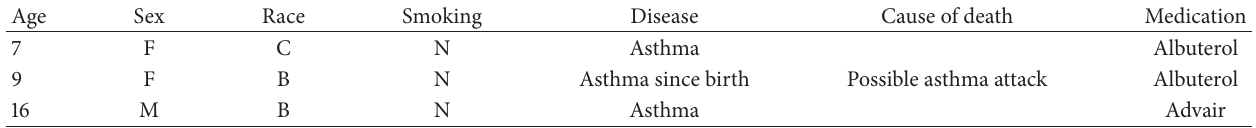
Table 1: Description of asthmatic human airway epithelial tissue